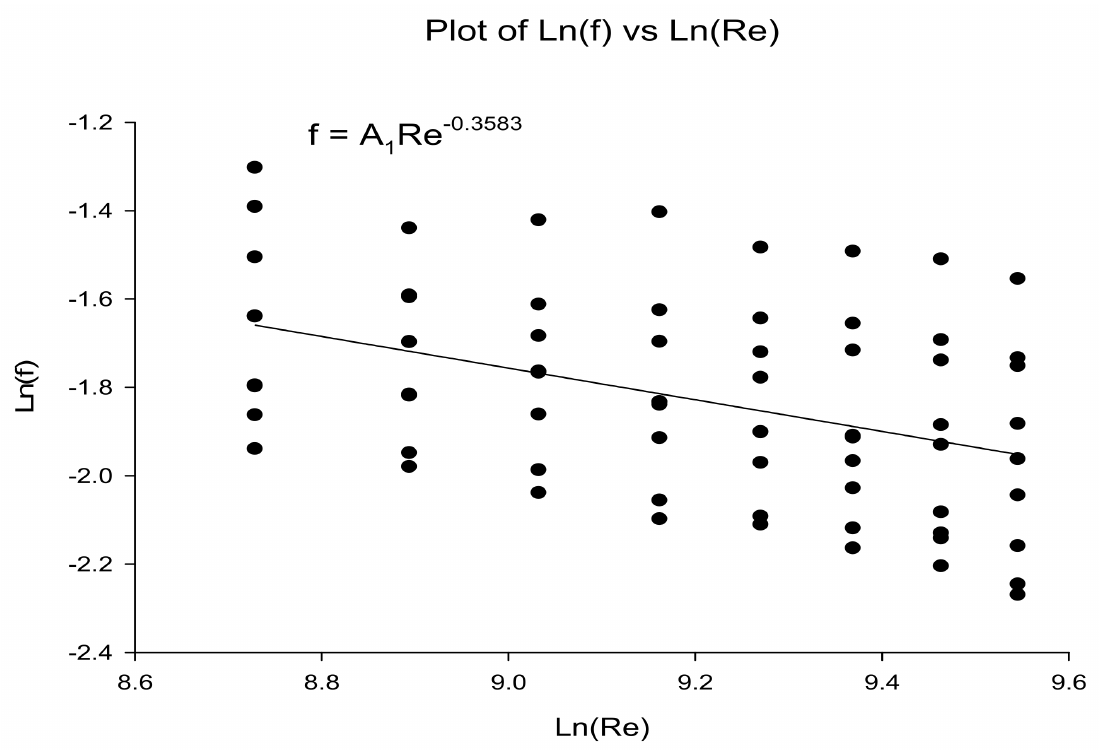
Figure 7. Experimental Variation of Friction Factor and Reynolds number.